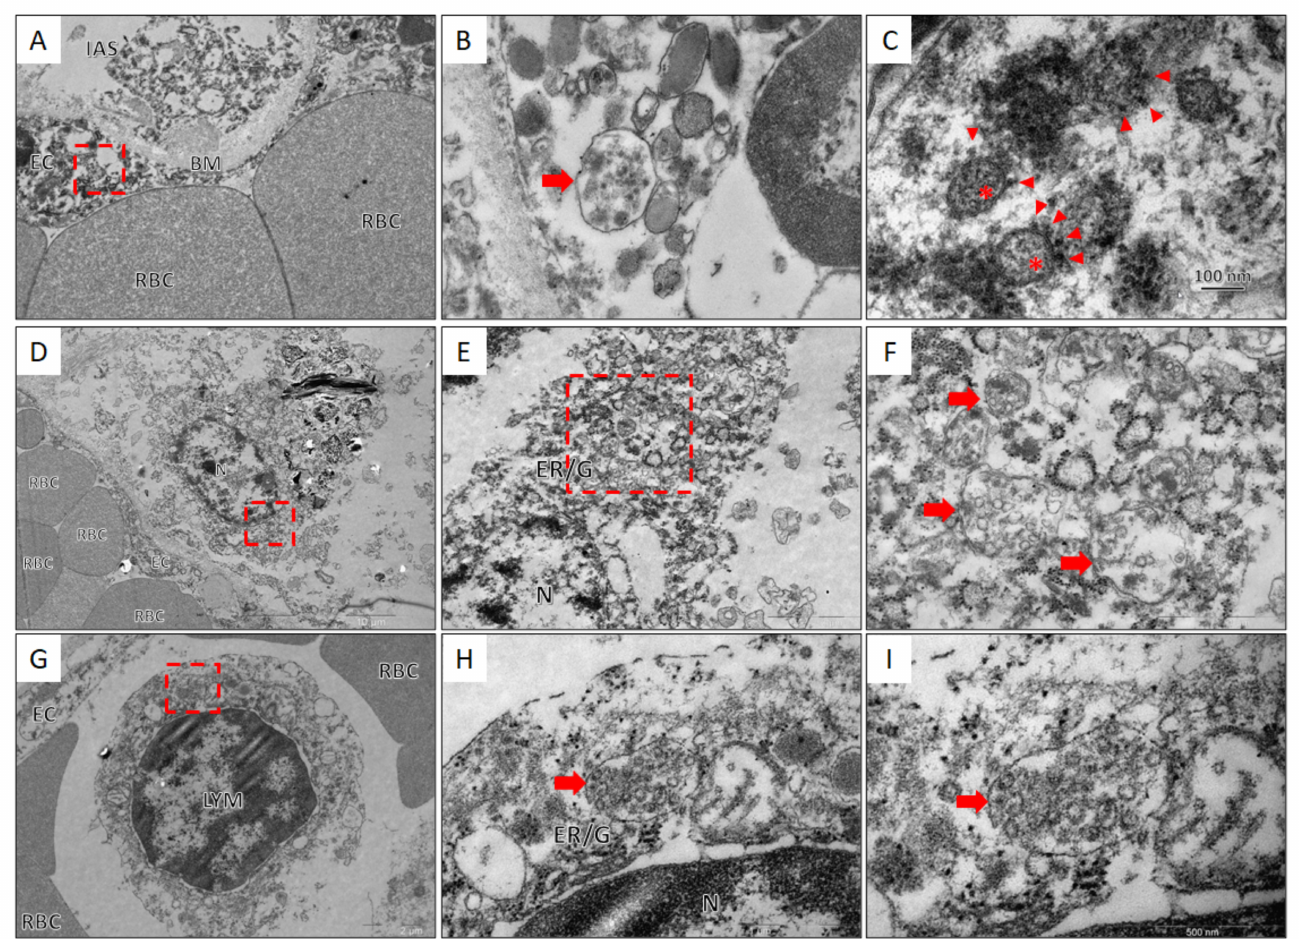
Figure 5. Results of TEM examination of lung tissue ( A–C ), tracheobronchial lymph nodes ( D–F ), and lymphocyte infected with SARS-CoV-2 coronavirus ( G–I ). ( A , B ) The section of the air-blood barrier is divided by the basement membrane (BM) into the intra-alveolar space (IAS) and the lumen of the capillary with red blood cells (RBC). In the cytoplasm of the endothelial cell (EC) (red frame), a membrane vesicle with spherical coronavirus particles inside is determined (red arrow). ( C ) At high magnification, the coronavirus particles were spherical, with an average size of 100 nm, surrounded by a membrane, on the surface of which there are electron-dense outgrowths of the S-protein (arrowhead), and granular nucleocapsid structures (asterisks) can be seen in the lumen of the particles. ( D , E ) In the lymph node, in the cytoplasm of a pericapillary macrophage (small red frame), multivesicular structures (large red frame) associated with the endoplasmic reticulum and cisterns of the Golgi complex (ER/G) were identified. (F) At high magnification, SARS-CoV-2 virions (red arrows) were seen inside the vesicles. ( G–I ) In the lumen of the capillary, along with erythrocytes (RBC), a lymphocyte (LYM) was found, in the cytoplasm of which (red frame) perinuclearly bound, a vesicle (red arrow) containing coronavirus particles was